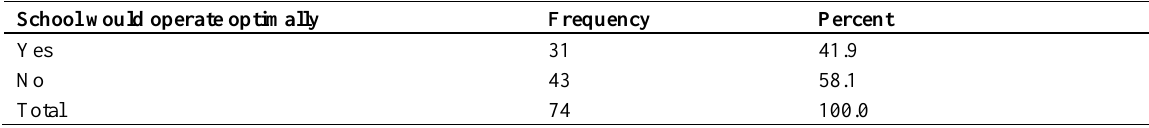
Table 4: Parents view on School Operations in the absence of Donor Funds